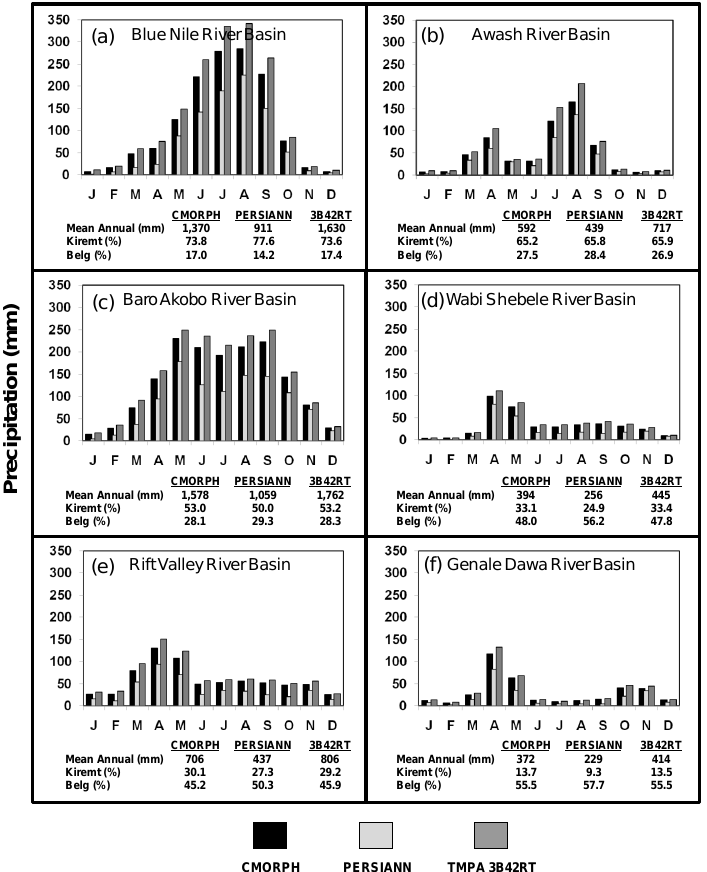
Figure 3 –Temporal Precipitation Pattern, 5 Year Monthly Average (2003 – 2007) Fig. 3. Temporal precipitation pattern, 5yr monthly average